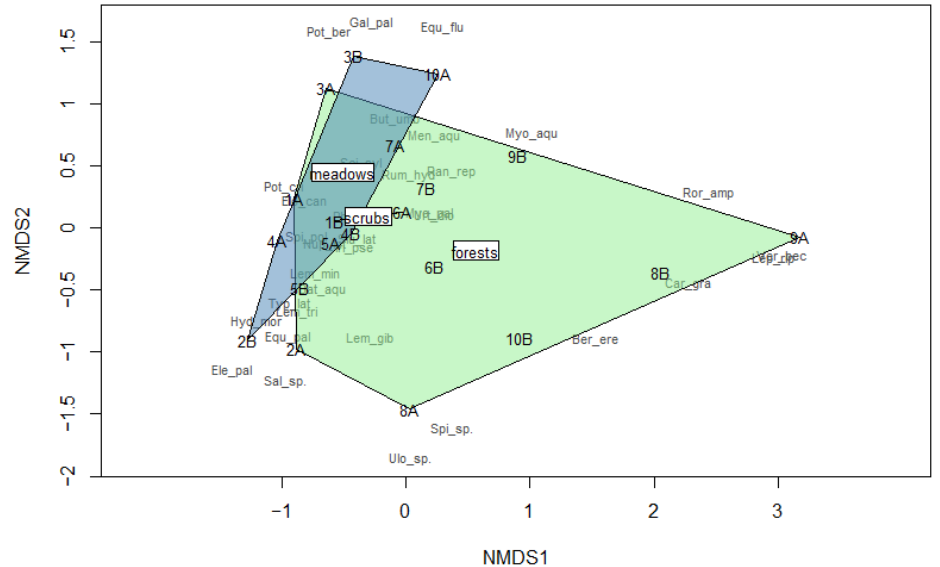
Figure 3. The impact of land use on the occurrence of plant species.